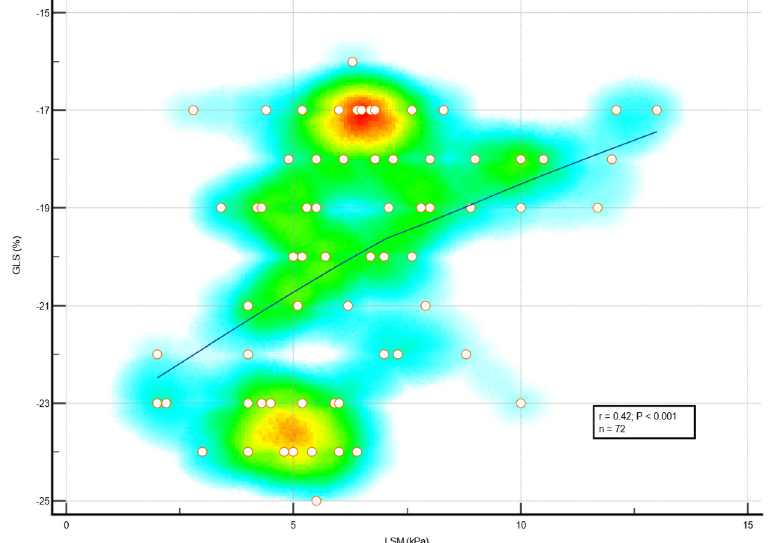
Figure 3. Correlation between LSM and global LV longitudinal strain in MetS patients with diabetes. Abbreviations: GLS, global longitudinal ventricular strain; LSM, liver stiffness measurement; MetS,